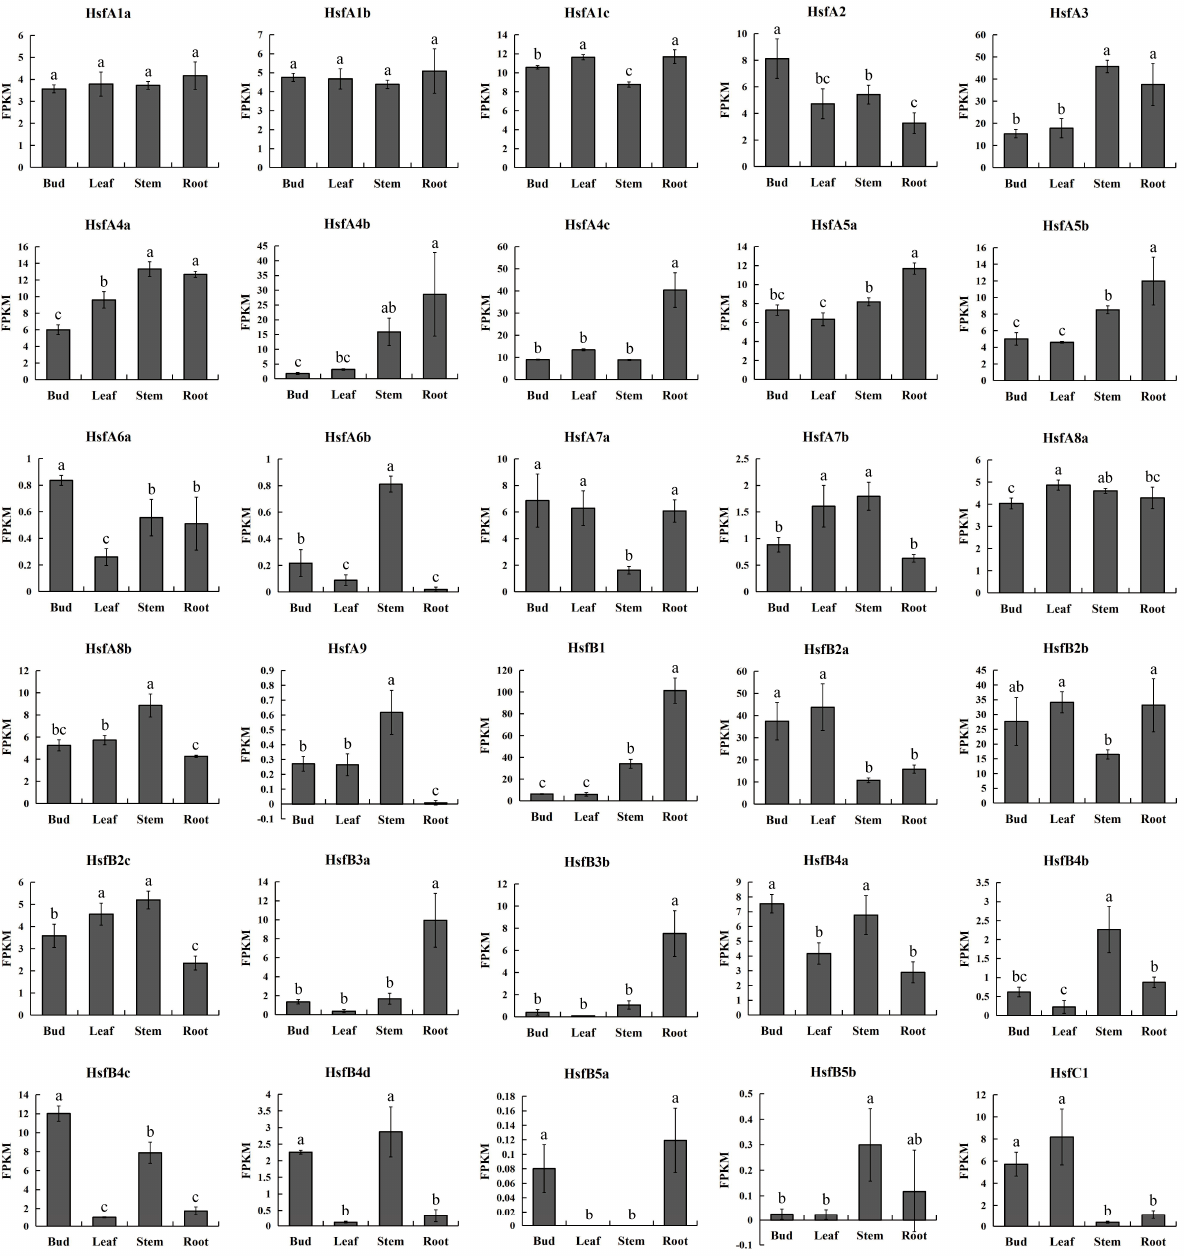
Figure 9. RNA-Seq analysis of poplar HSF genes during early development. The bud, leaf, stem, and root tissues of one-month-old poplar tissue culture seedlings were collected for sequencing. Gene expression was standardized using FPKM. Error bars are standard deviations from the biologic replicates. Different lowercase letters represent significant differences between groups (One-way ANOVA, p < 0.05).